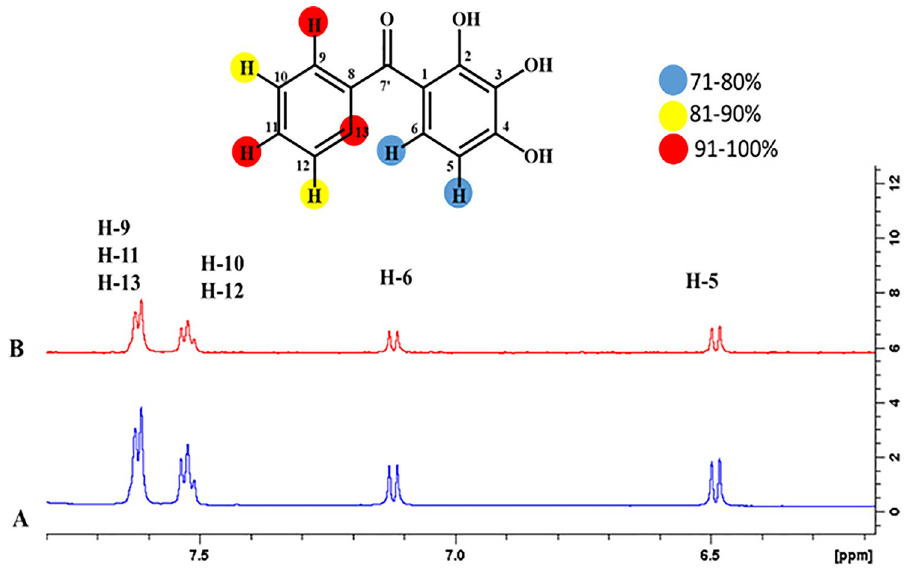
Fig 16. (A ) Reference 1 H-NMR spectrum of ligand 1 . (B) Difference spectrum of ligand 1 with the enzyme.